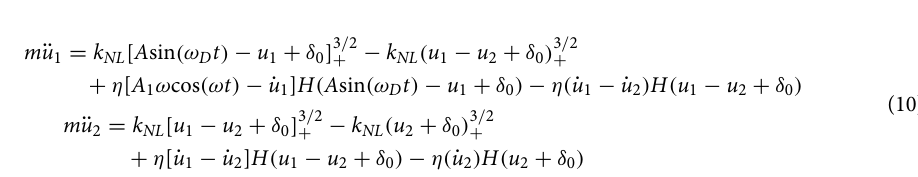
Figure 3. Experimental realization of time-dependent superposition of states. Schematic illustration of the experimental instrumentation used for the two-granule nonlinear system. The system is longitudinally driven by a single transducer at one end, and a set of transducers are utilized to detect the longitudinal modes of the